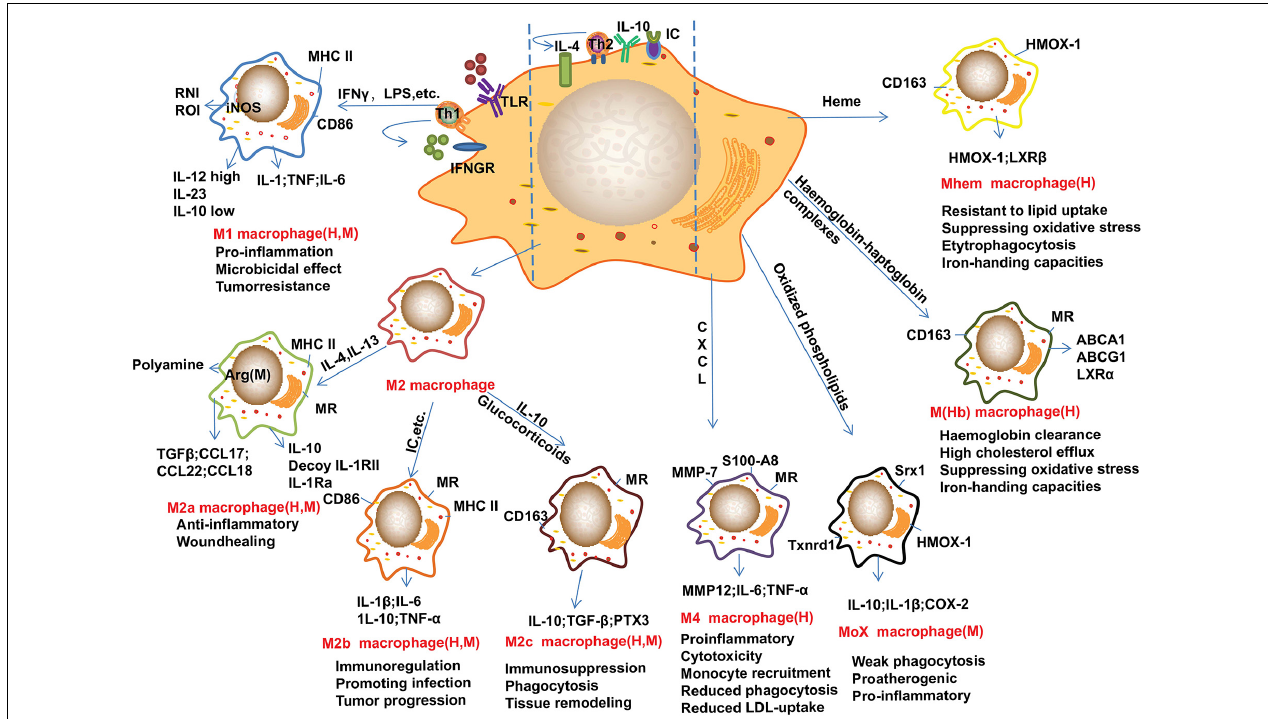
FIGURE 1 | Main subtypes of macrophages found in atherosclerotic plaques. Distinct stimuli in atherosclerotic microenvironment drive distinct macrophage phenotype differentiation. This figure points out some examples of these macrophage markers or related genes, and the subtypes of macrophages are identified in human (H) and/or mouse (M) atherosclerotic plaques. M1 macrophages can be induced by IFN- γ and LPS, these cells mainly show pro-inflammatory effect. M2 macrophages can be induced by IL-4 and IL-13, and IL-10, these cells can be further divided into M2a, M2b, and M2c subtypes. Of note, these cells are found not always protective. Furthermore, monocyte/macrophage can be differentiated into Mox, M4, M(Hb), and Mhem subtypes by distinct factors or microenvironments. Arg-1, arginase-1; CD, cluster of differentiation; CXCL, Chemokine (C-X-C motif) ligand; HMOX-1, heme oxygenase-1; IC, immune complexes; iNOS, inducible nitric oxide synthase; IFN- γ , interferon- γ ; IL, interleukin; LPS, lipopolysaccharide; LXR, liver X receptor; MHC, major histocompatibility complex; MMP, Metalloproteinase; MR, mannose receptor; Srx1, sulforedoxin-1; Th, T-helper; Txnrd1, thioredoxin reductase 1; TLR, Toll-like receptor; TGF β , transforming growth factor β . These abbreviations are suitable for the following